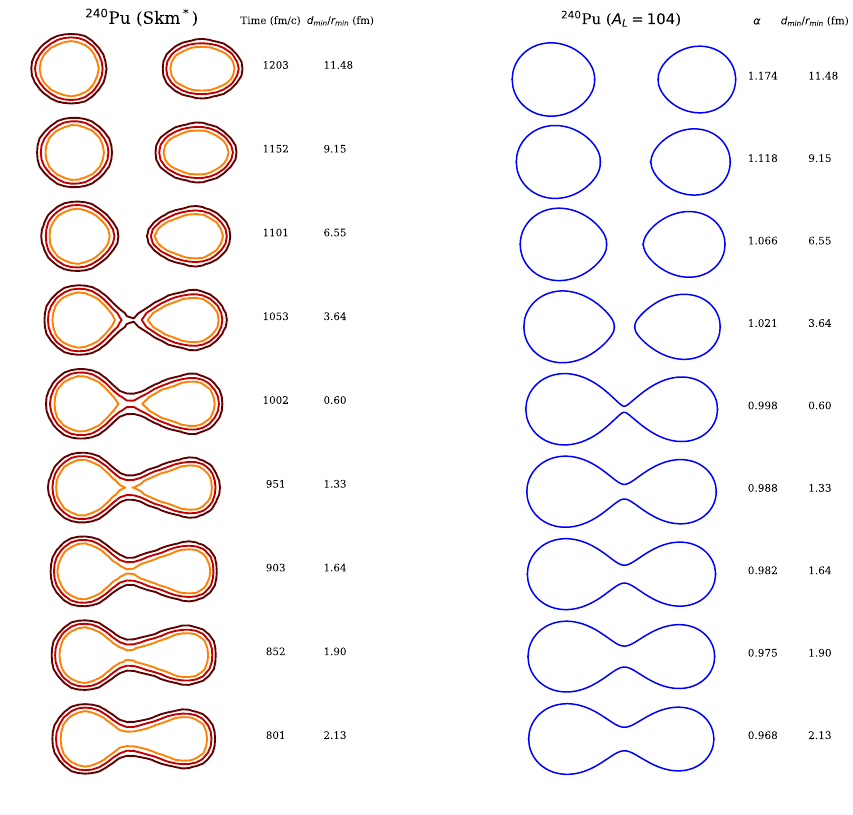
Table 1. Scission neutron multiplicity: 240 Pu , A L = 104, 0 . 968 >> 1 . 174, ∆ T = 13 . 4